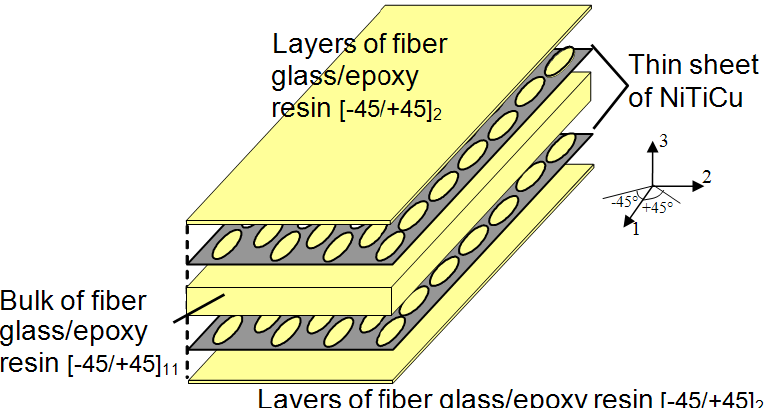
Figure 3: Architecture of the new proposed hybrid